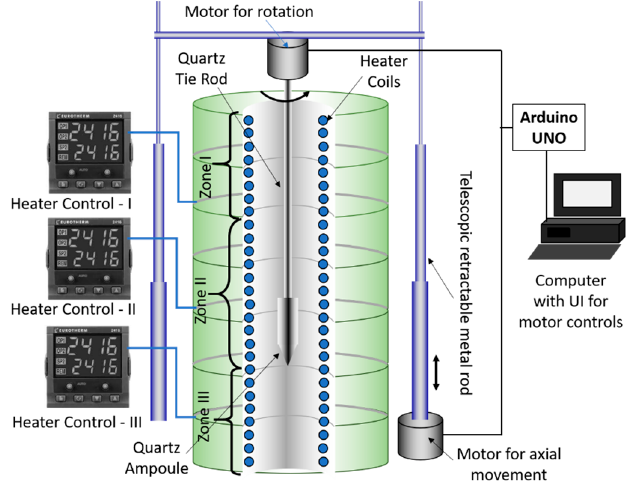
Figure 5. Schematics of a vertical furnace arrangement for vertical Bridgman growth. Yakimov et al. used a horizontal Bridgman method to grow single crystals of CZTS with a growth rate of 1–4 mm/h [23]. They used commercially available 6N purity CZT and 4N5 purity CdSe as precursor materials along with elemental Cd to create Cd overpressure in order to suppress the formation of Te inclusions. They have also used In doping (~3 ppm by weight) for compensation. The obtained 4 mm thick wafers contain several large grains suitable for detector